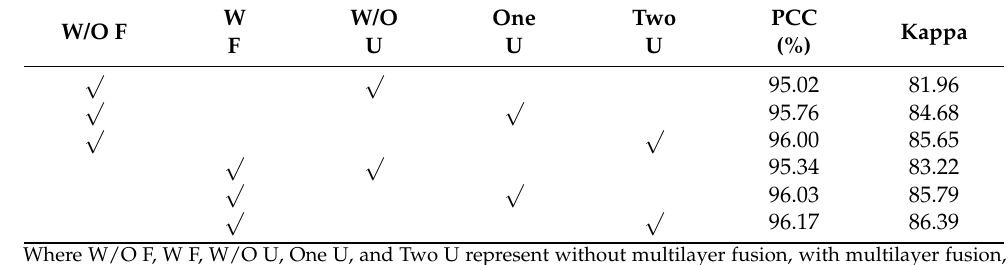
Table 8. Analysis of the network and updating function.